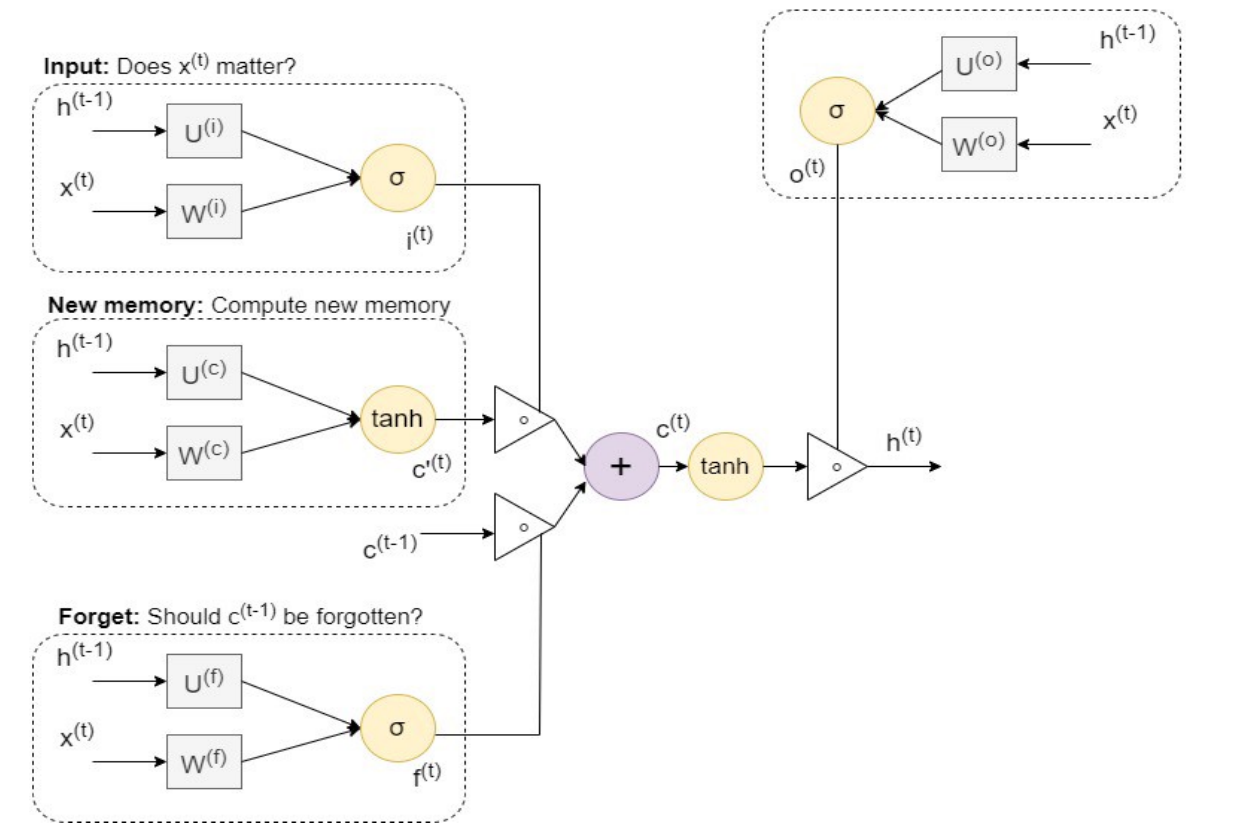
Figure 4. Structure of the LSTM model.